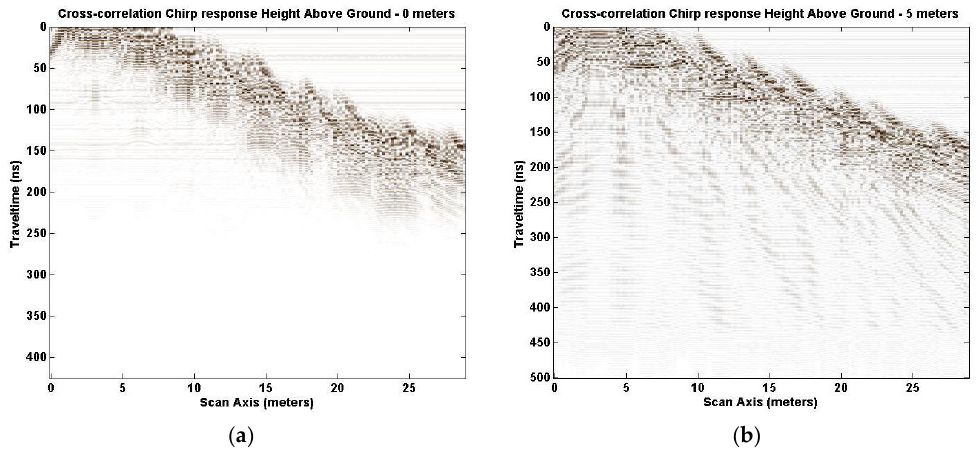
Figure 17. ( a ) Cross-correlation of chirp excitation response of SA2 model for Tx/Rx pair at 0 m above ground. ( b ) Cross-correlation of chirp excitation response of SA2 model for Tx/Rx pair at 5 m above ground.